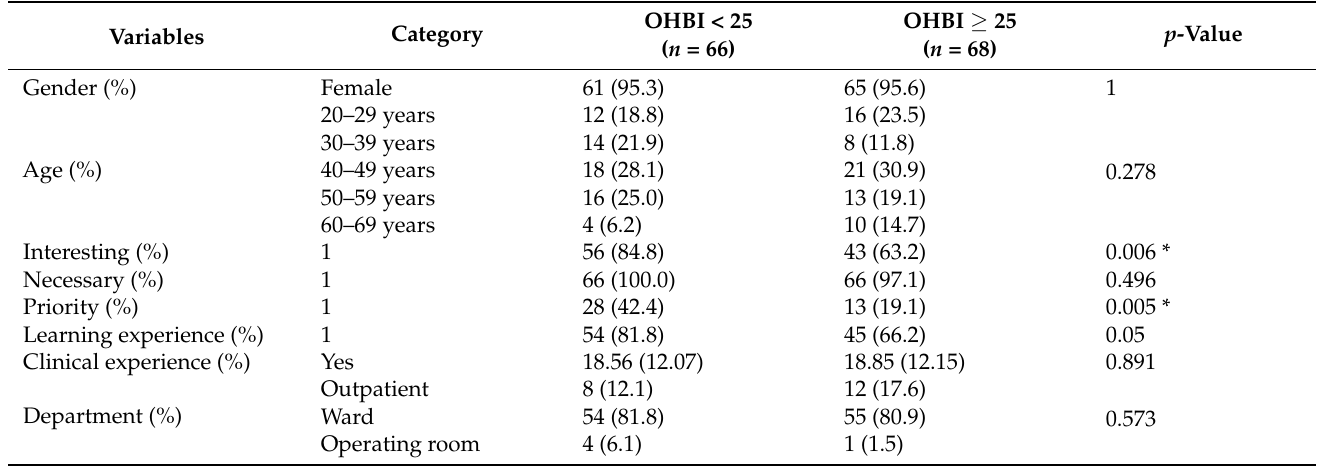
Table 4. Factors related to the burden of oral care in univariate